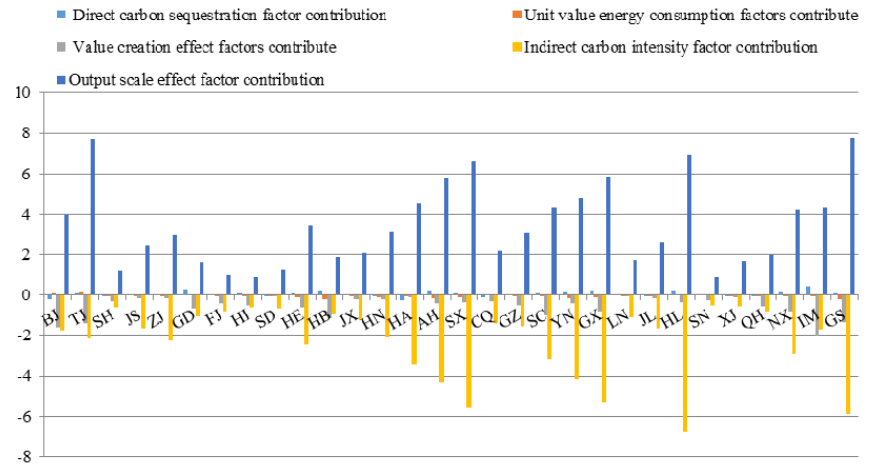
Figure 3. Construction industry carbon emissions factor decomposition in China.